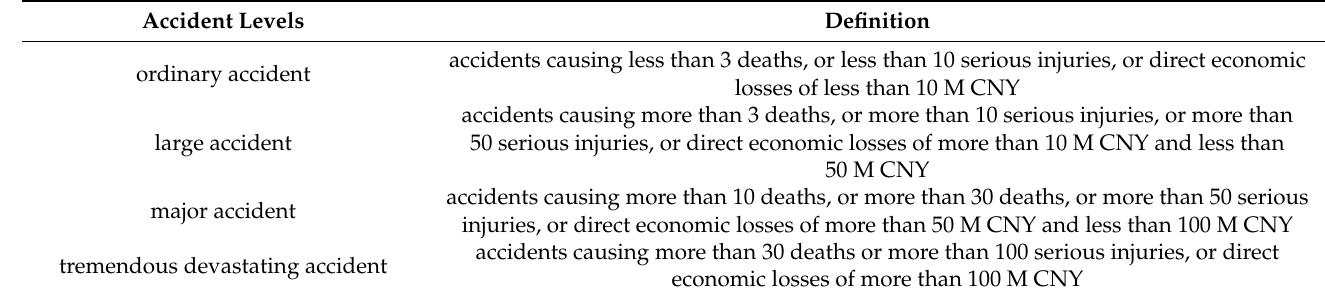
Table 1. Accident levels and definitions of